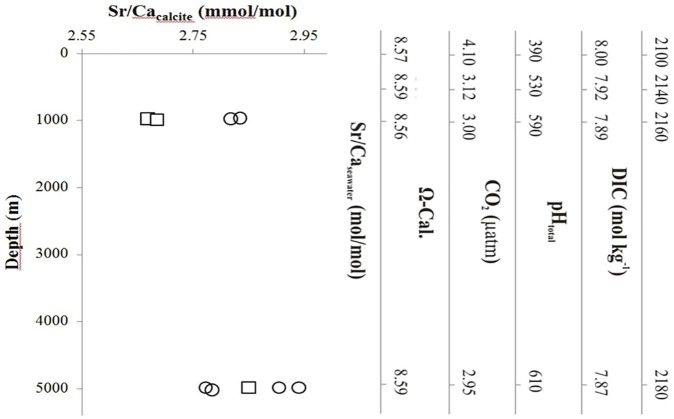
The relationship of E. huxleyi strains (CCMP 88E: circles, and NZEH: squares) calcite Sr/Ca with the seawater conditions from different depths and thus a natural carbonate chemistry gradient.Axes on the right show experimental medium carbonate chemistry conditions and seawater composition in the incubations (no pressure effect). Each data point represents an individual measurement.